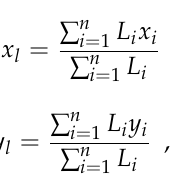
Table 1. Results conducted using complex network analysis (CAN) in a complex network framework. Centrality Type Closeness Centrality Bus